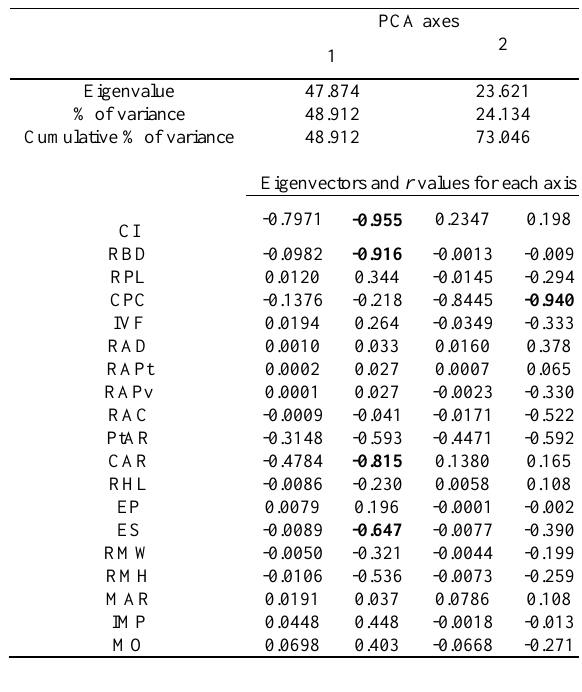
Table 5. Eigenvalues, eigenvectors, and variance extracted for the two principal axes of PCA. The correlation index values in bold type ( i.e. , r> 0.6; negatives or positives) between each ecomorphological attribute and the correspondent axis were used to interpret the distribution of the 17 nektonic fish species in the graphic of PCA (see Fig. 2). CI = compression index; RBD = relative body depth; RPL = relative peduncle length; CPC = caudal peduncle compression index; IVF = index of ventral flattening; RAD = relative area of dorsal fin; RAPt = relative area of pectoral fin; RAPv = relative area of pelvic fin; RAC = relative area of caudal fin; PtAR = pectoral fin aspect ratio; CAR = caudal fin aspect ratio; RHL = relative head length; EP = relative eyes position; ES = relative eye size; RMW = relative mouth width; RMH = relative mouth height; MAR = mouth aspect ratio; IMP = index of mouth protrusion; MO = mouth